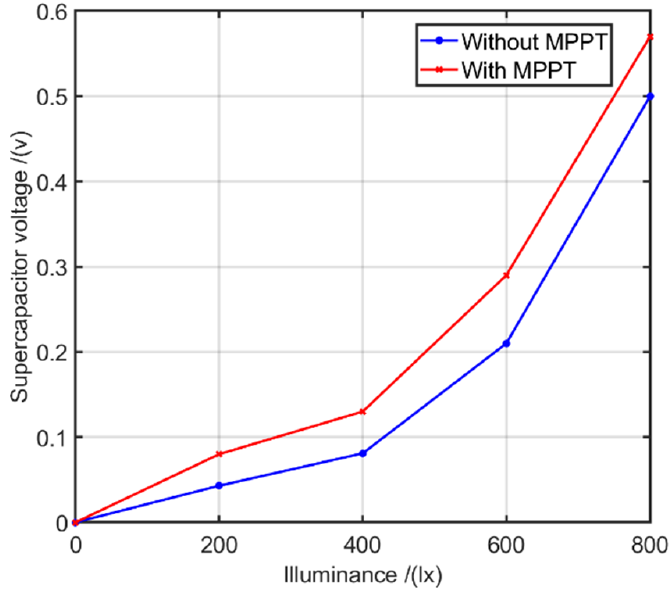
Figure 14. Capacitor voltage variation with and without MPPT.